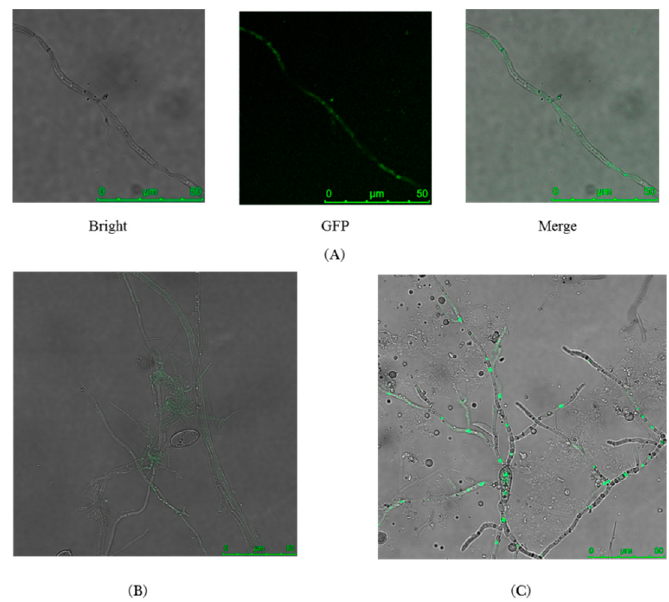
Figure 3. Detection of MoMCP1-GFP in M. oryzae . ( A ) The distribution of MoMCP1-GFP in the hypha, and ( B ) conidia; ( C ) The distribution of the green signal in the branched hypha that germinated from the conidia; scale bar, 50 µm.